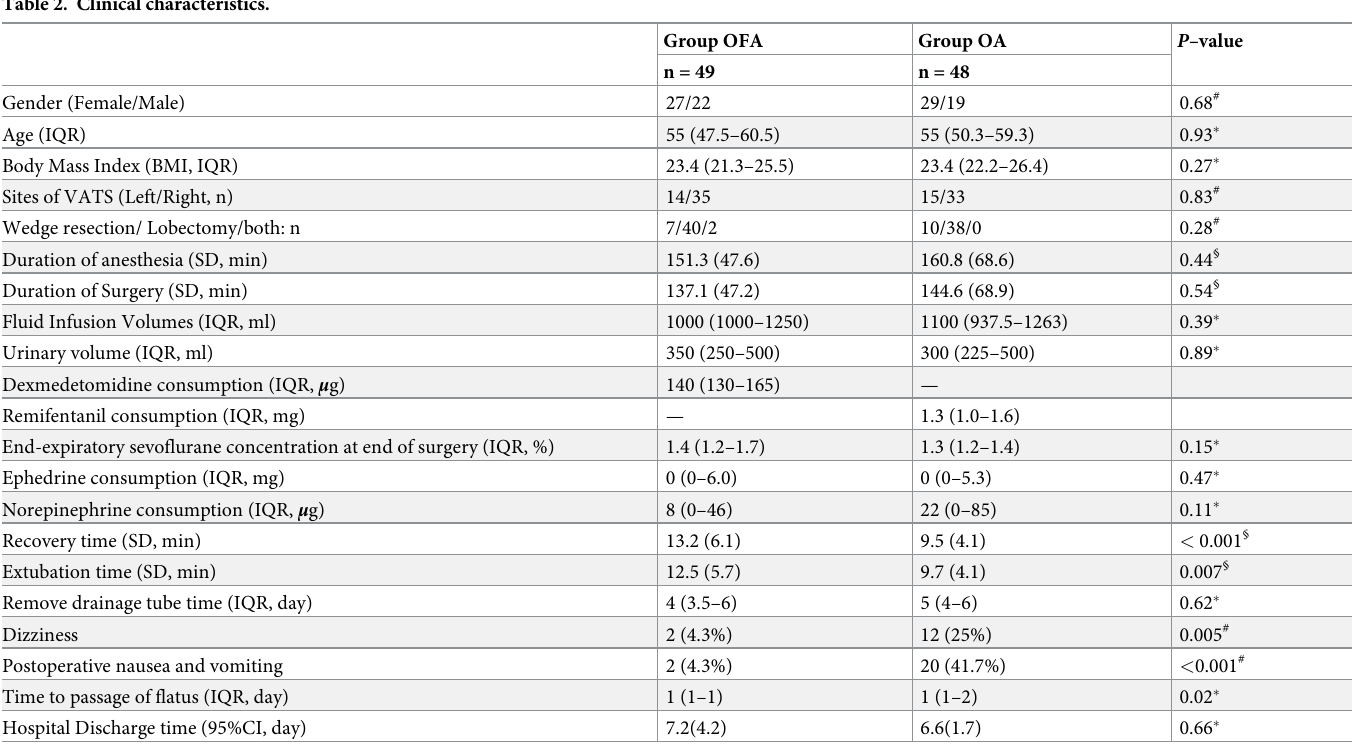
Table 2. Clinical